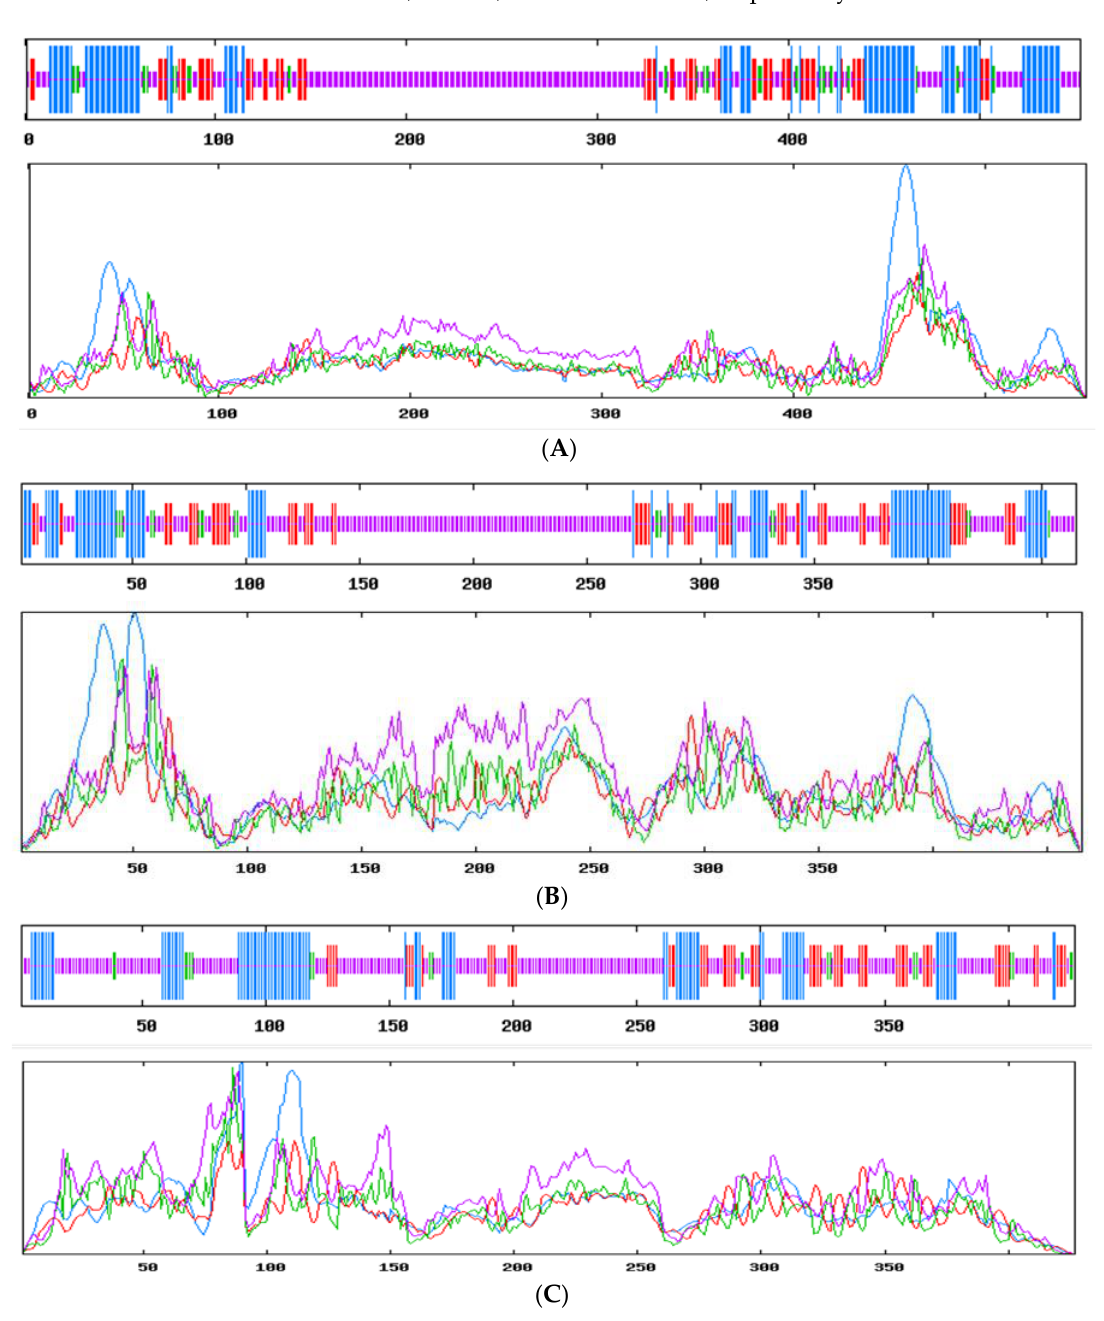
Figure 4. Secondary structure of SMAD4 ( A ), SMAD5 ( B ) and SMAD7 ( C ).